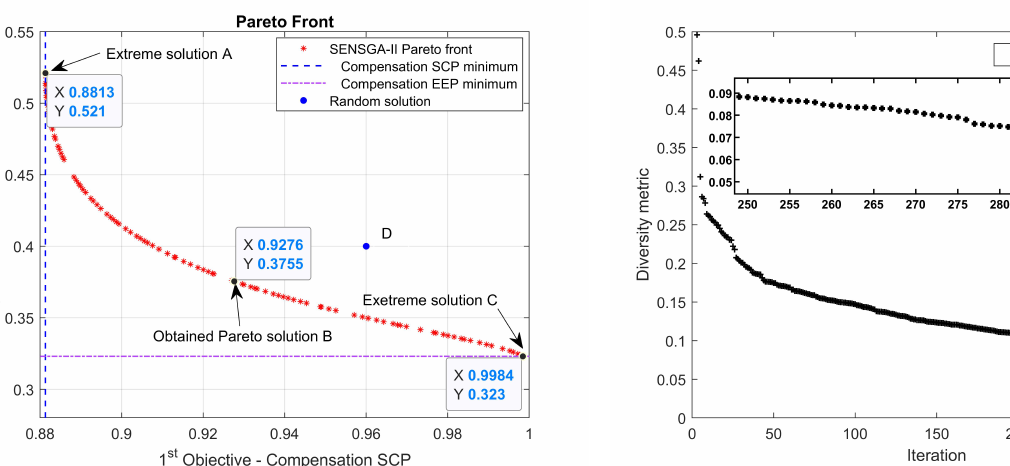
Figure 6. The Pareto front shows the optimal results for the two goals of (P2).